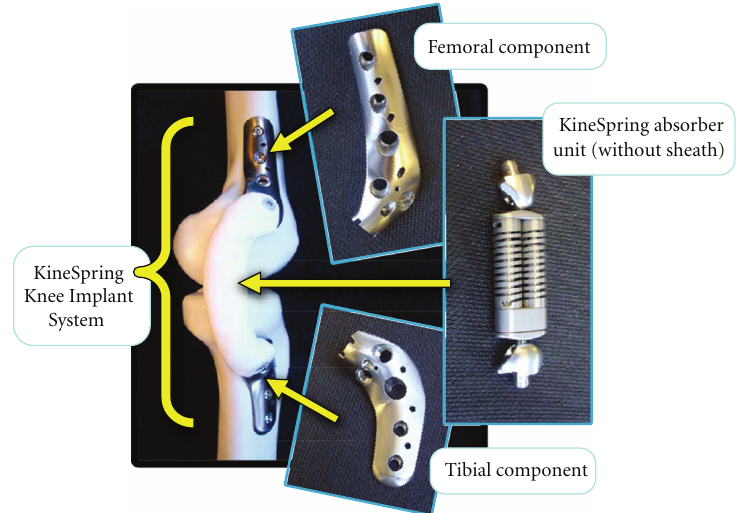
Figure 2: Components of the KineSpring Knee Implant